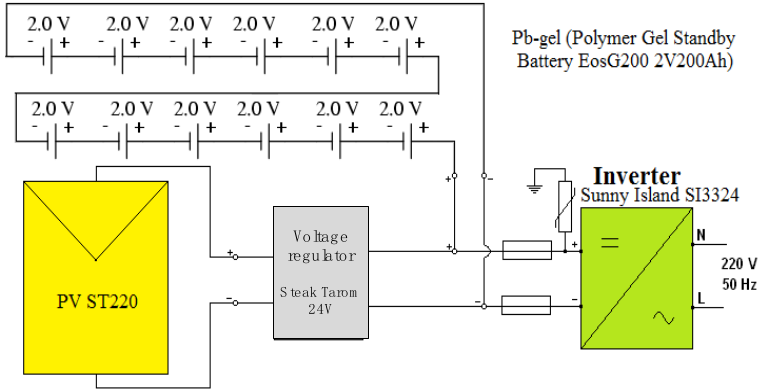
Figure 5. Block diagram of Subsystem 2 connected to the grid.